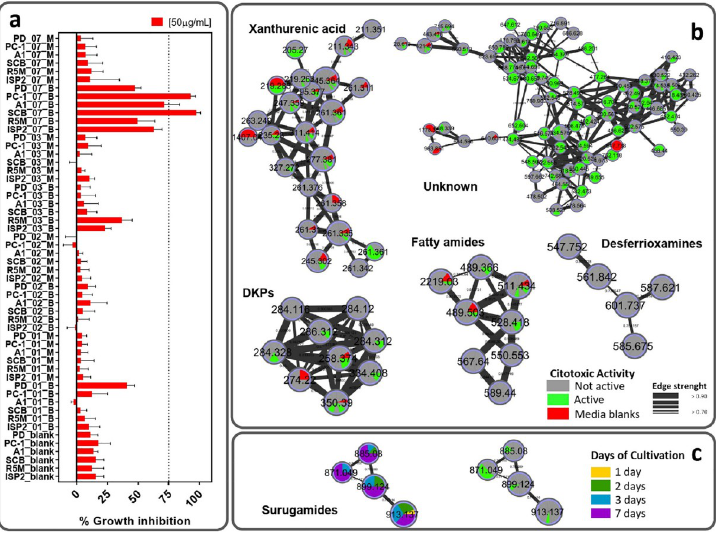
Fig 7. Cytotoxic evaluation of the crude extracts (50 μ g/mL) produced by Streptomyces sp. BRB081 on HCT-116 cell lines by the MTT assay. a) Samples activities expressed as percentage considering the positive control as 100% of inhibition. Over 75% of growth inhibition threshold was determined as the parameter for positive activity. Samples code representation: Medium_Days_Part (B–Broth; M–Mycelium). b) Clusters of identified compounds colored by the activity they displayed (active/non active). c) Comparison between observed activity and days of cultivation of the surugamides cluster.